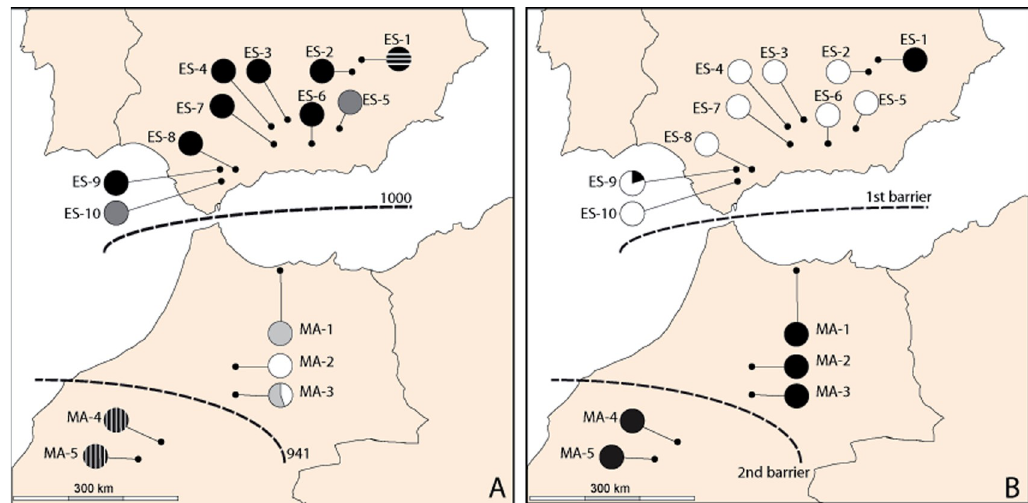
Fig 4. Geographical distribution of the best K value inferred by the software BAPS and barriers to gene flow. (A) K = 6 for AFLP results. (B) K = 2 for plastid DNA dataset. Dotted lines represent the barriers to gene flow detected by the Barrier software. Barriers for AFLP data are based on 1000 bootstrapped F ST matrices.